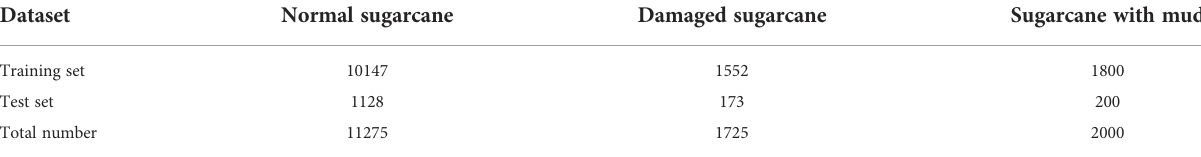
TABLE 1 Sugarcane sample